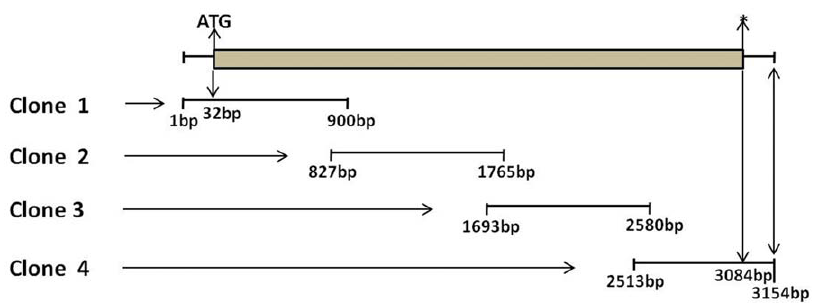
Figure 6. Schematic illustration showing the cloning strategy for the water buffalo COL6A1 gene. Different overlapping clones of the water buffalo COL6A1 gene were generated to obtain the full length cds. Shown here are the nucleotide boundaries and positions of start and stop codons.